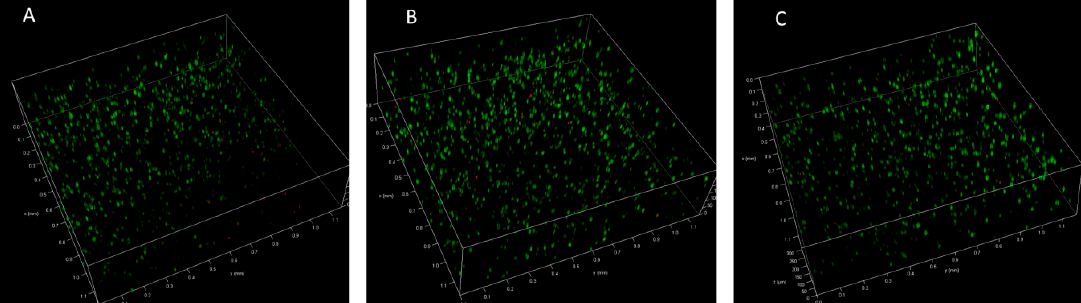
Figure 9. Live-dead assay of encapsulated ATDC-5 cells in HA/PEG hydrogel ( A ) 1 day; ( B ) 4 days; ( C ) 7 days. (Living cells appearing green and dead cells appearing red).